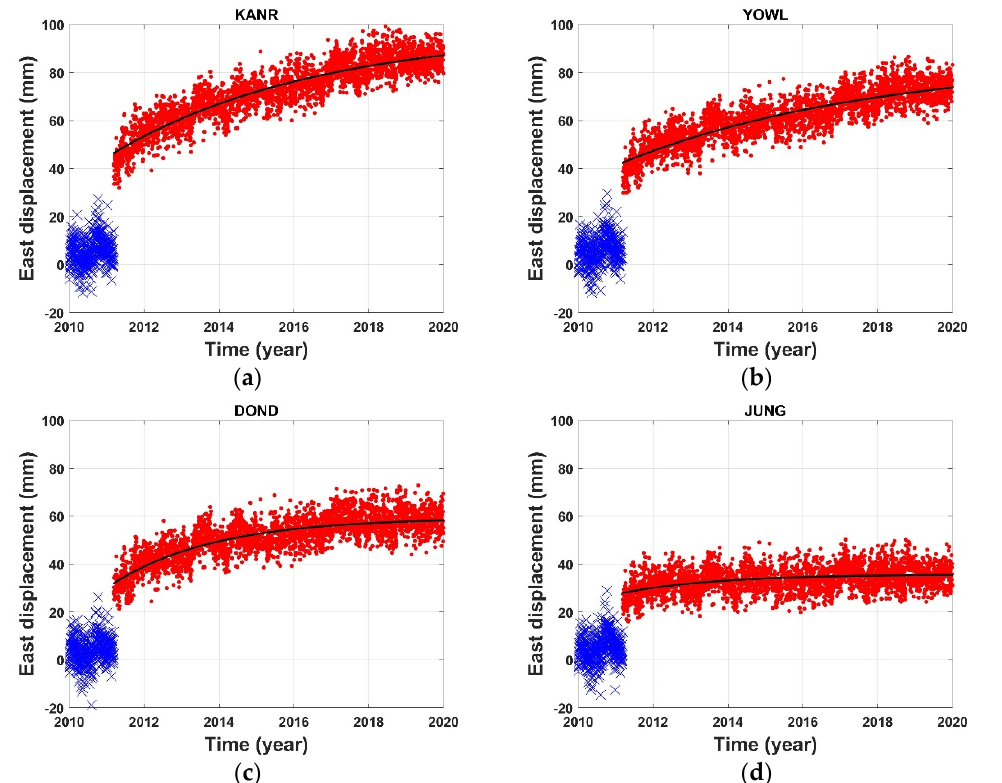
Figure 4. Post-seismic time-series for the east components of four GPS stations: ( a ) KANR, ( b ) YOWL, ( c ) DOND, and ( d ) JUNG. These four GPS stations are located 1183, 1228, 1339, and 1398 km away from the epicenter, respectively. The blue crosses represent the pre-seismic displacements, while the red dots denote the post-seismic displacements. The black lines are exponential fitted curves using GPS data.